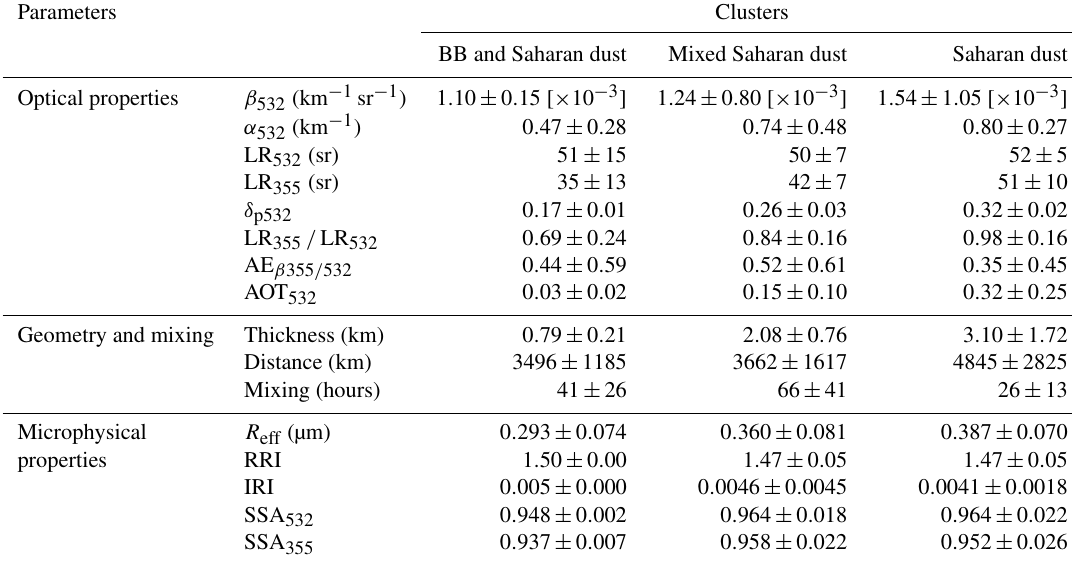
Table 4. Mean values of optical, geometrical and microphysical properties of the three identified clusters, along with their standard deviation (SD). Zero SD indicates no variability in the corresponding retrieved parameter. The term “mixing” refers to the hours the air masses traveled after leaving the African